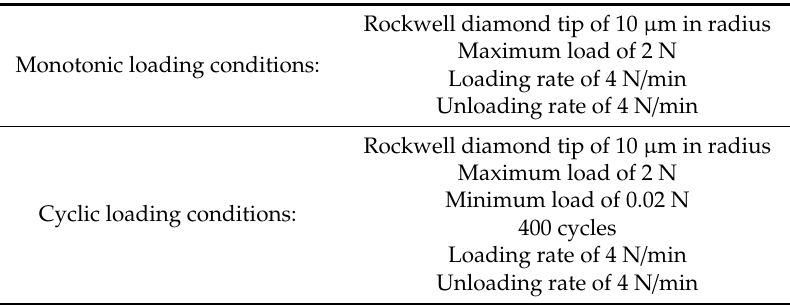
Table 6. Monotonic and cyclic loading conditions.